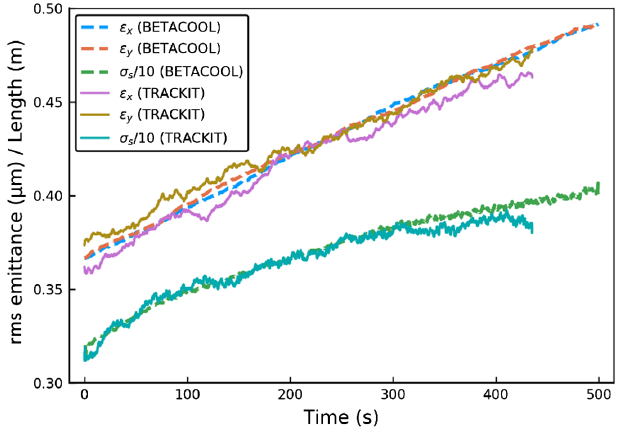
FIG. 3. Comparison of the growth of rms beam emittances = ε ( ε ) and rms bunch length ( σ x y marking with BETACOOL